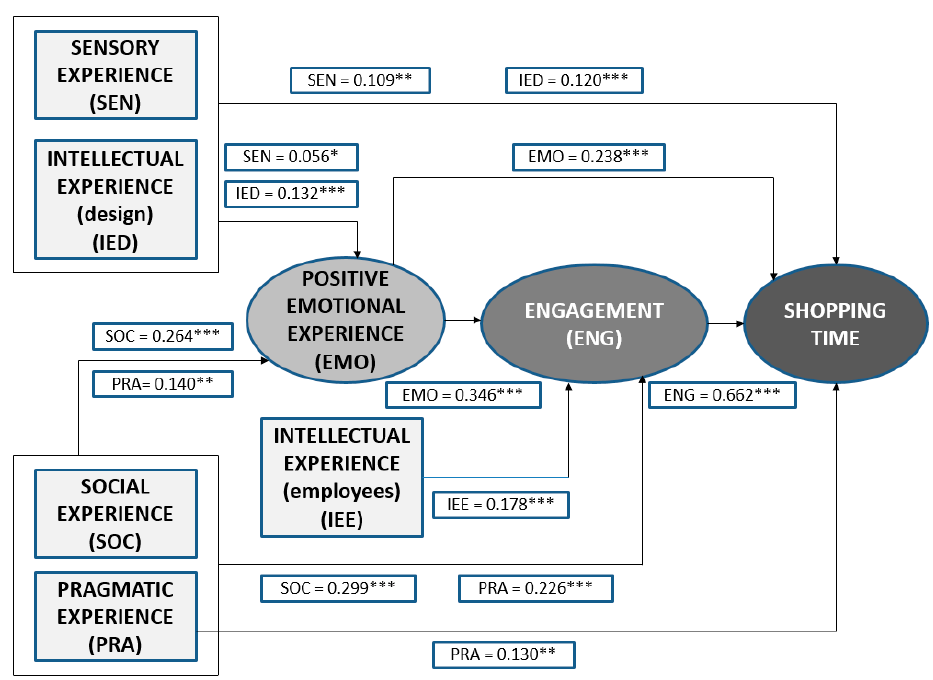
Figure 2. Significant relationships between all of the variables studied. * p < 0.05; ** p < 0.01; *** p < 0.01.